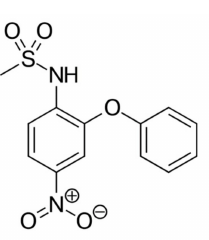
Figure 3. Nimesulide structure.